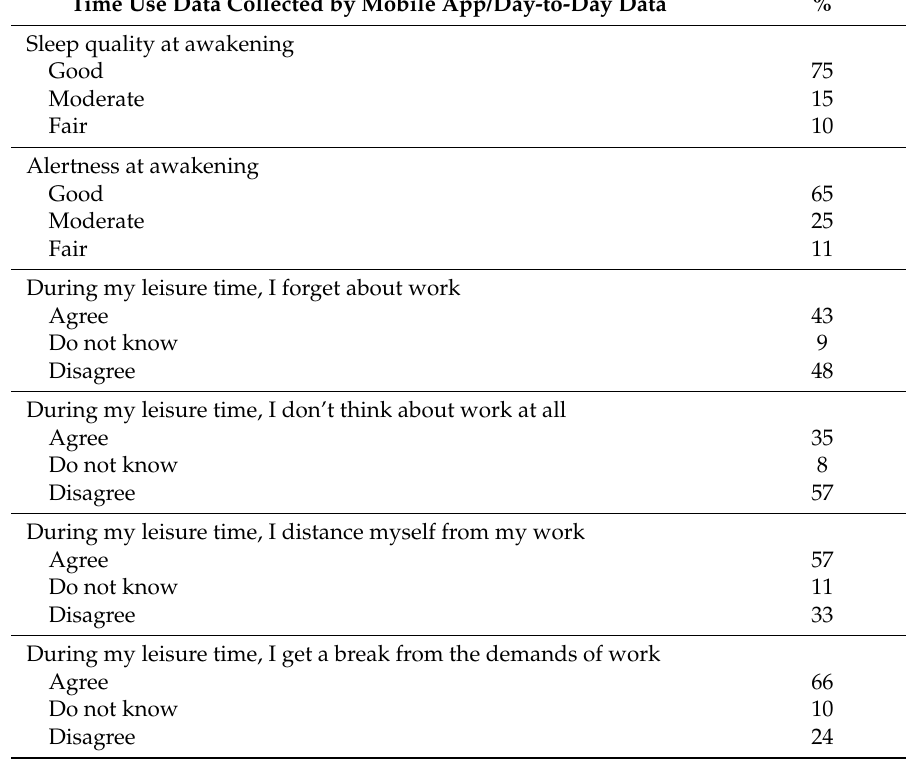
Table 2. Percentages of day-to-day ratings of mean sleep quality, alertness, recovery, and detachment from work.